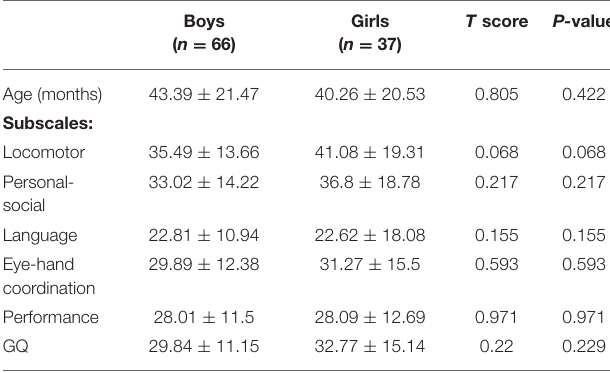
TABLE 5 | Sex differences in developmental levels a